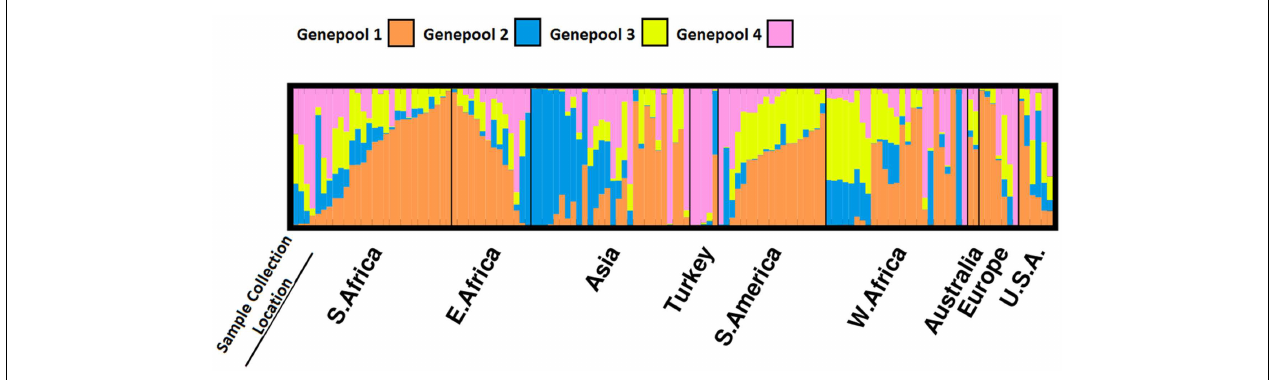
FIGURE 3 | Population structure underlying a subset of the USDA core collection of cowpea. Samples are first sorted based on their geographic location of collection and then sorted based on a coancestry matrix with K =